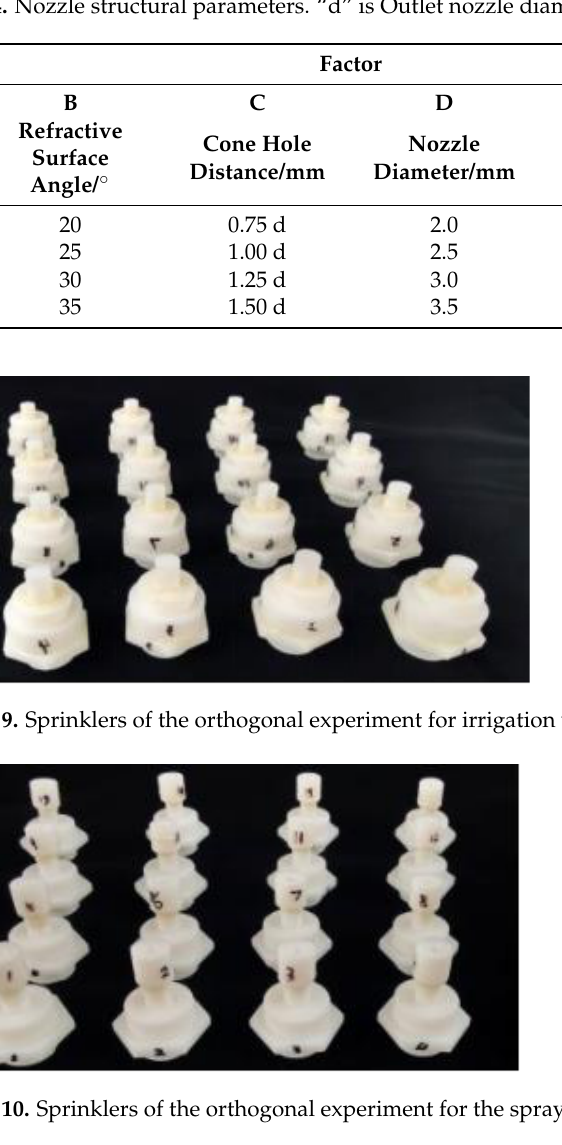
Table 5. Results of the tests for the performance of irrigation water.